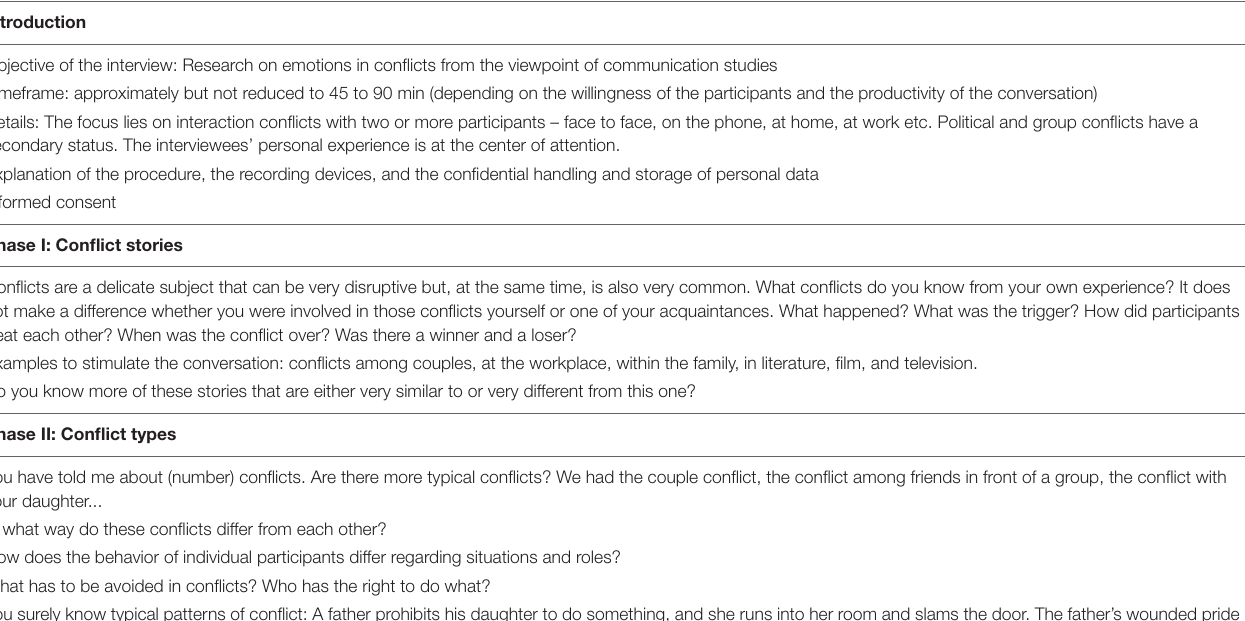
TABLE 1 | Interview